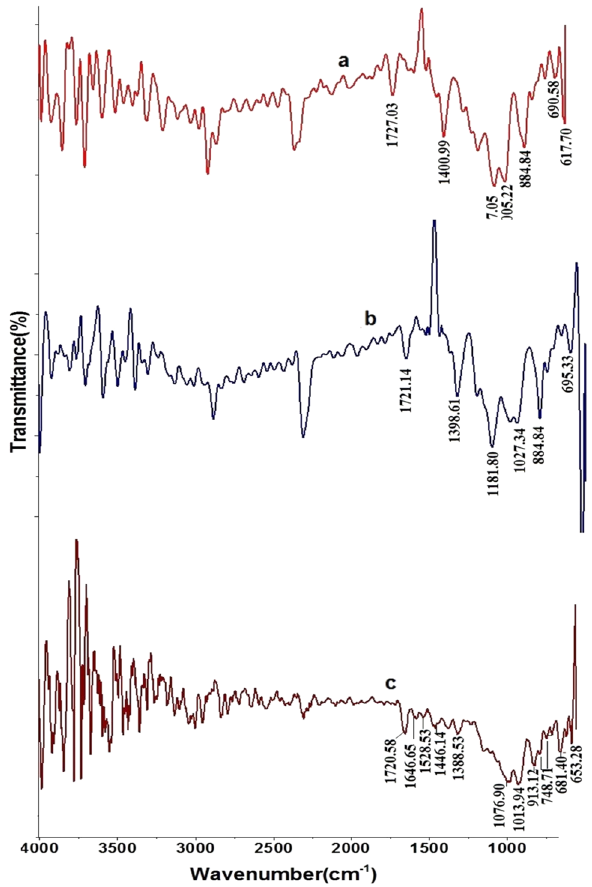
Fig. 2 FTIR spectra of a PVdF, b PVdF–PMMA (80:20), and c PVdF–PMMA (50:50) nanofibrous membranes